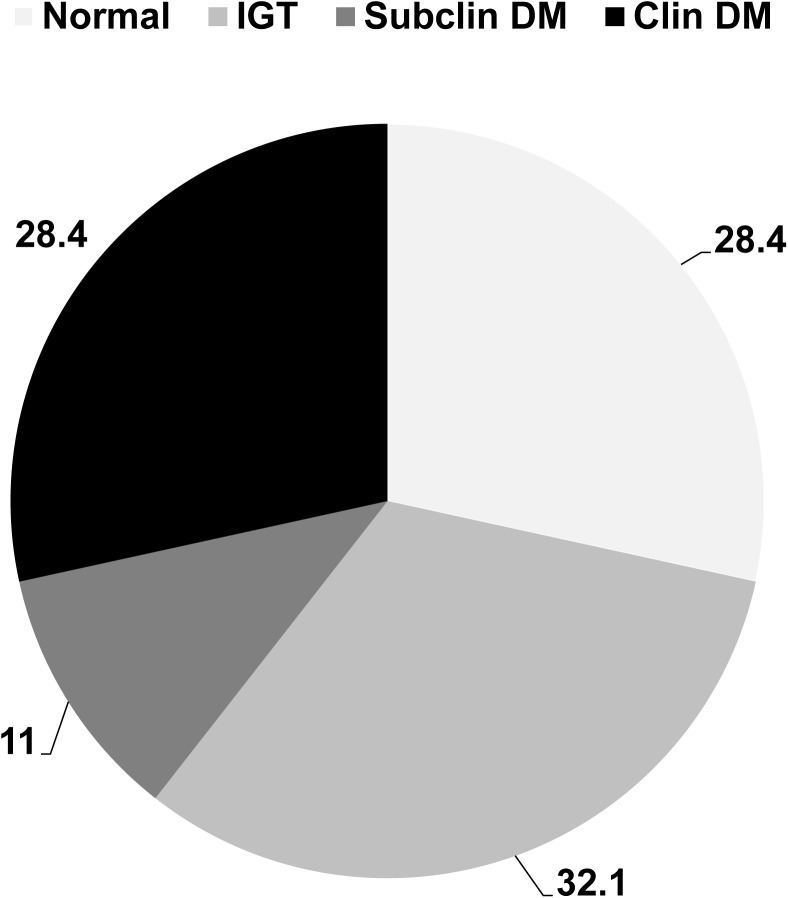
Distribution of glucose abnormalities among NASH patients after oral glucose tolerance test.IGT, impired glucose tolerance; subclin DM, subclinical diabetes mellitus; Clin DM, clinical diabetes mellitus.